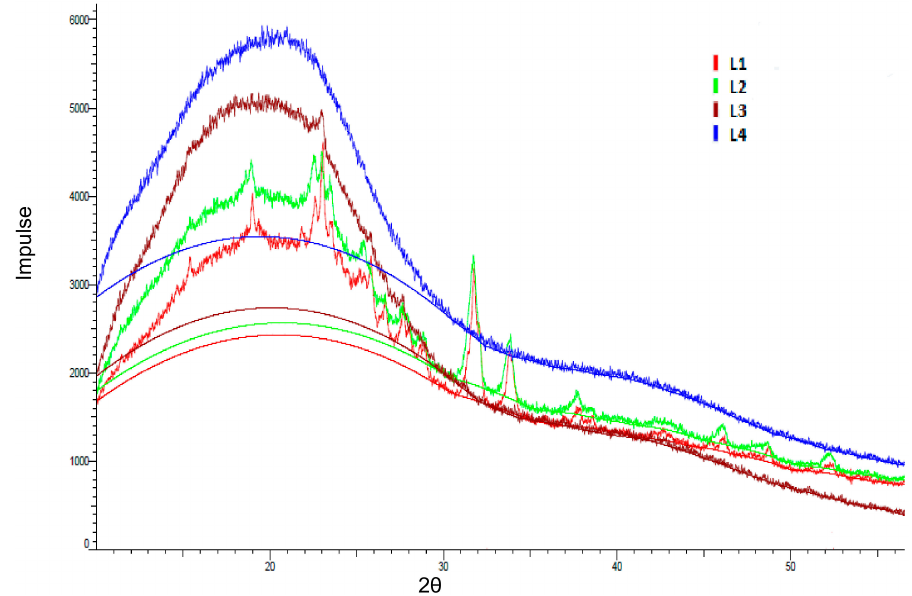
Figure 11. X-ray diffraction (XRD) diffractogram of the kraft lignin purification fractions L1 (red), L2 (green), L3 (brown), and L4 (blue).